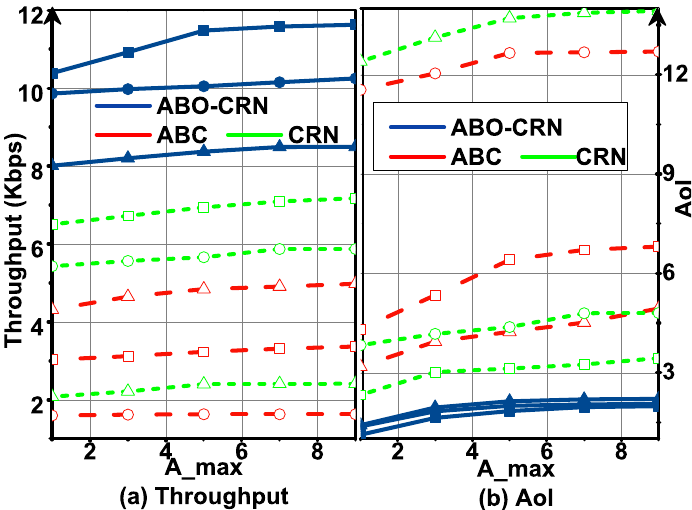
Figure 9. Throughput T and AoI versus A max under P a = 0.3 (circle), 0.6 (square), 0.9 (triangle) compared with that in the ABCs and CRNs, and T min = 700 bps: ( a ) describes the throughput performance. ( b ) describes the AoI